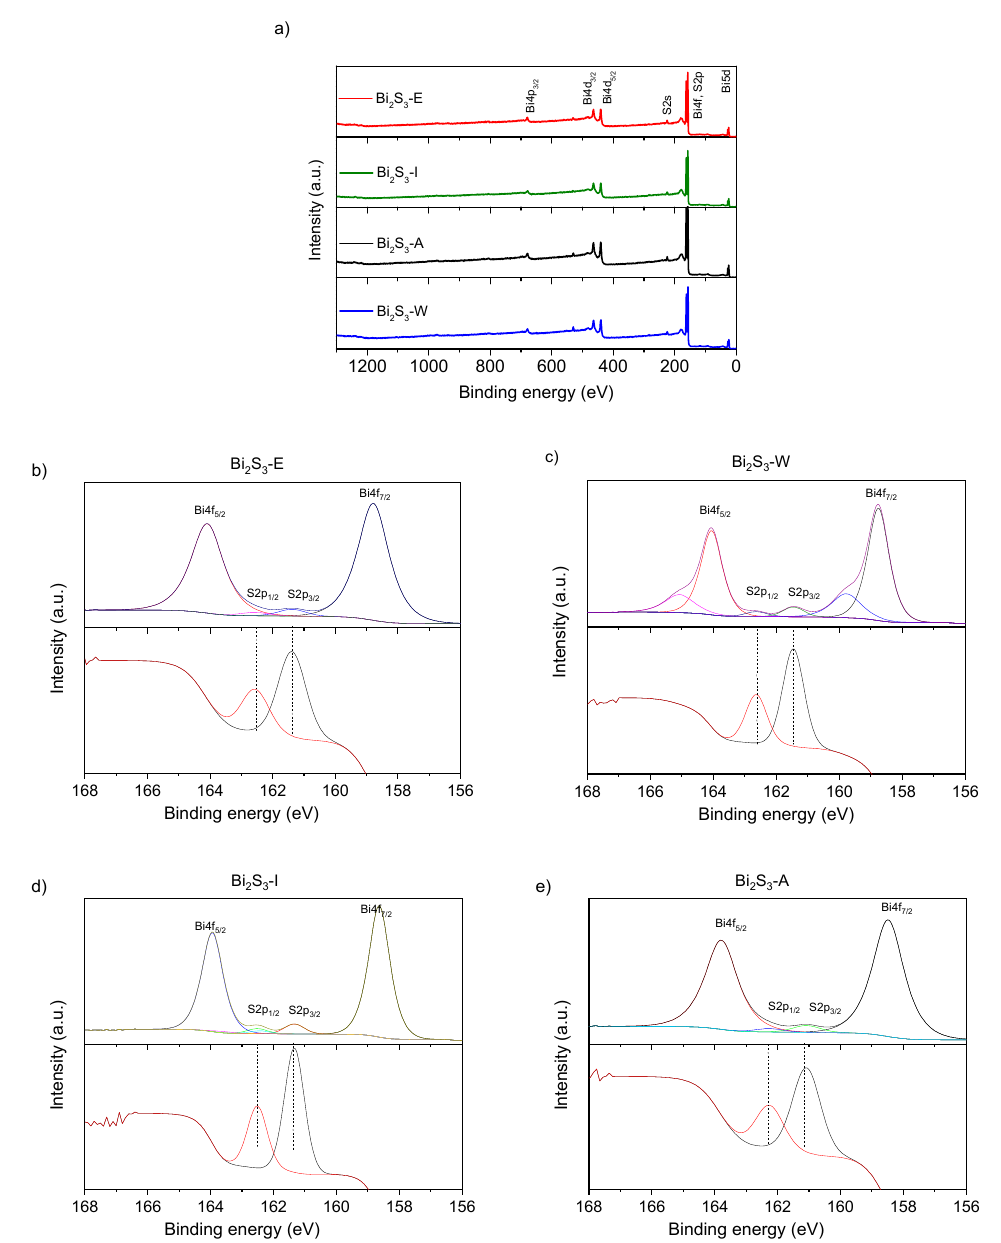
Figure 4. XPS survey spectra ( a ), Bi 4f and S 2p regions of Bi 2 S 3 (upper graph and lower graph, indicated within yellow color range, respectively), regions of Bi 2 S 3 obtained in various solvents ( b – e ).